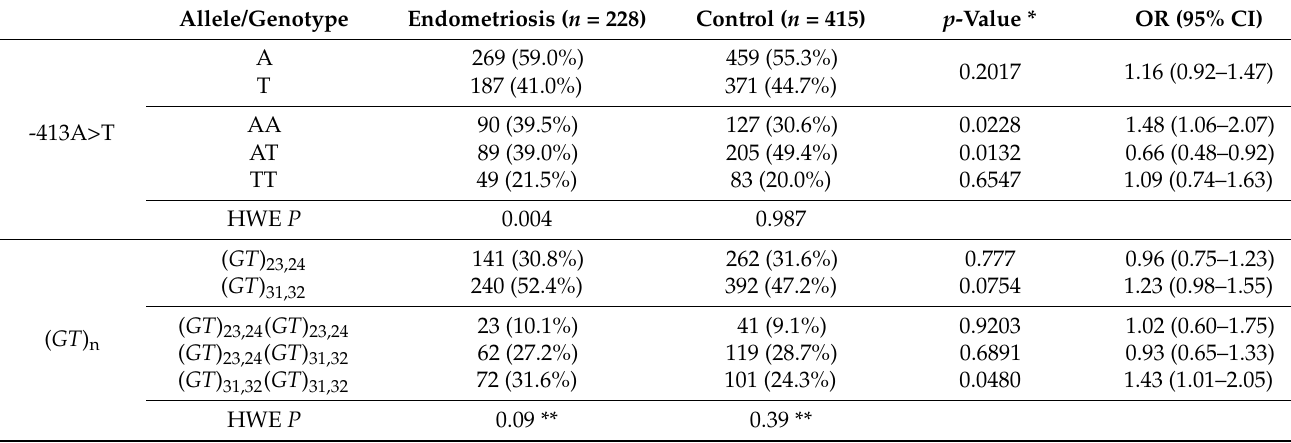
Table 1. Allele and genotype distribution of − 413A>T SNP (single-nucleotide polymorphism) and two most frequent ( GT ) n dinucleotide repeat variants of HMOX1 gene in patients with endometriosis and control